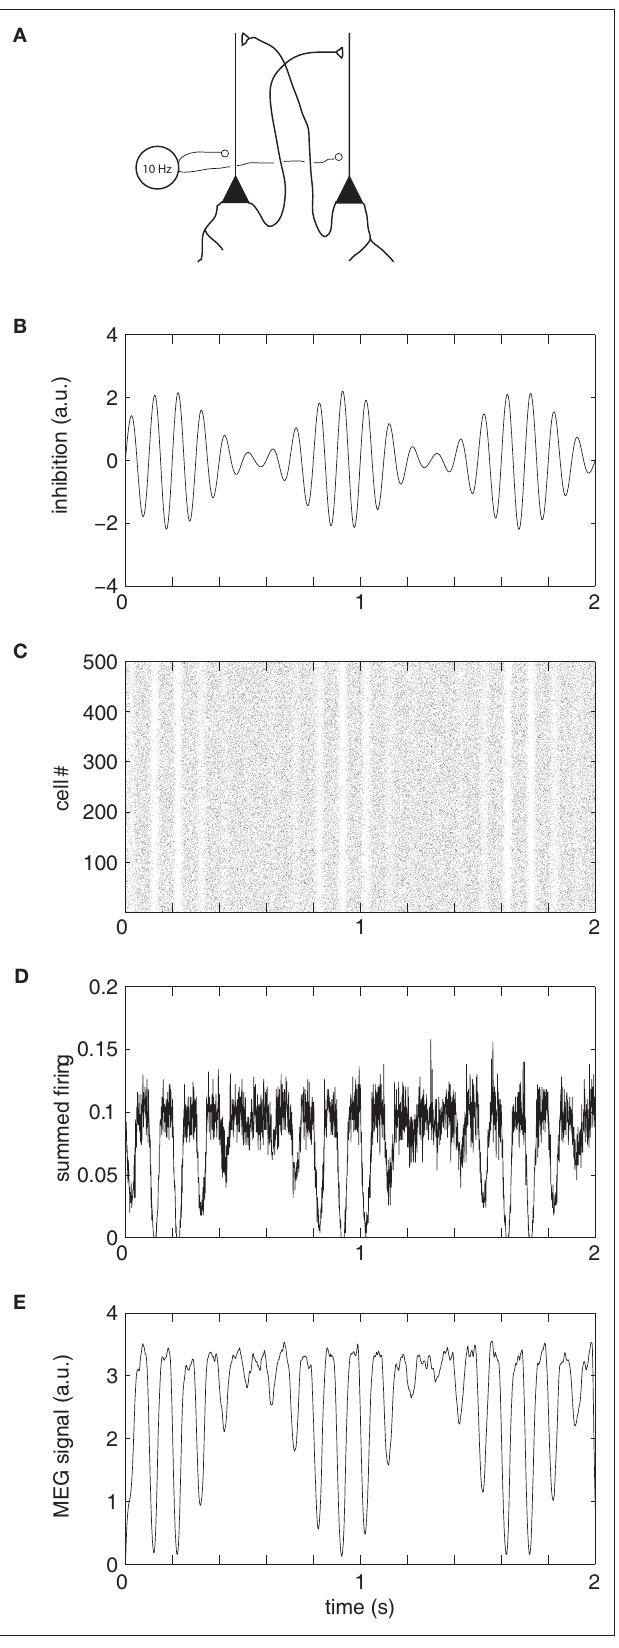
Figure 9 | A simple model explaining how pulsed inhibition is reflected in neuronal firing of pyramidal cells and subsequently the Meg signal. (A) Pyramidal cells are mutually synaptically coupled. The synaptic currents produce the MEG signal. We here assume a Poisson distribution of firing which is phasically silenced by an inhibitory GABAergic signal. (B) The signal at 10 Hz exercises an inhibitory drive silencing the firing of the pyramidal cells in a phasic manner. The magnitude of the inhibition is modulated by an arbitrary slower signal. (C) A raster diagram showing the firing of 500 pyramidal cells. The bouts of inhibition serve to silence the firing. In periods when the inhibition is low, the firing will persist (e.g., 0.4–0.6 s). (D) The summed firing of all the pyramidal cells (summed using a ∆ t = 1 ms sliding time window). (e) Each spike was convolved with an alpha-function ( α ( t ) = ( t / τ ) e 1 − ( t / τ ) , where τ = 5 ms) in order to approximate the post-synaptic current. These post-synaptic currents were then averaged over the pyramidal neurons. The “MEG signal” (arbitrary units, arbitrary offset) is proportional to the total dendritic current. Note that the inhibition results in a rhythmically pulsed MEG signal with amplitude